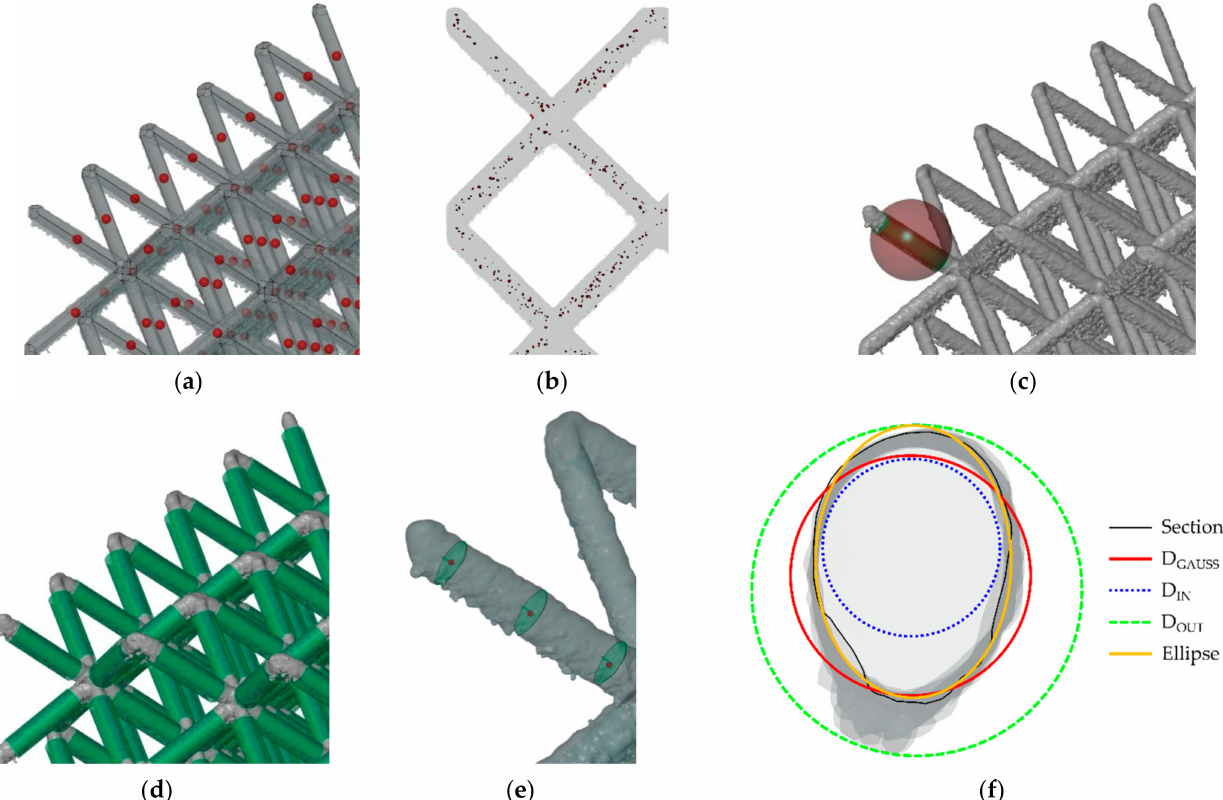
Figure 4. The procedure of lattice structure descriptive elements creation for the ( a ) polygonal mesh and CAD import; ( b ) deletion of internal voids; ( c ) strut’s data selection by sphere; ( d ) cylinders’ fitting; ( e ) points, planes, and sections creation and ellipses fitting; ( f ) dimensions